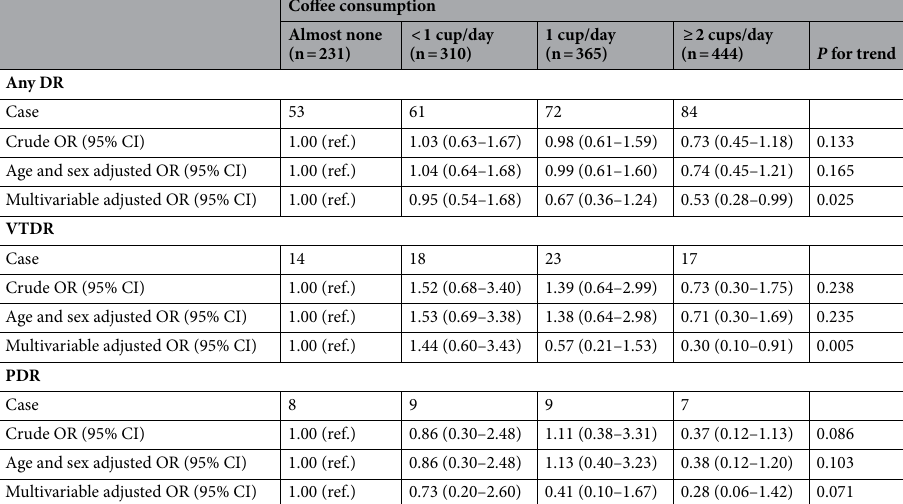
Table 2. The prevalence of DR by frequency of coffee consumption from the food frequency questionnaire among participants with type 2 diabetes (n = 1350). Multivariable adjustments included age, gender, education, occupation, income, body mass index, energy intake, hypertension, dyslipidemia, duration of diabetes, glycated hemoglobin (%), smoking, drinking, and physical activity (aerobic, moderate, walking level). DR, diabetic retinopathy; PDR, proliferative diabetic retinopathy; VTDR, vision-threatening diabetic retinopathy; OR, odds ratio; CI, confidence interval.